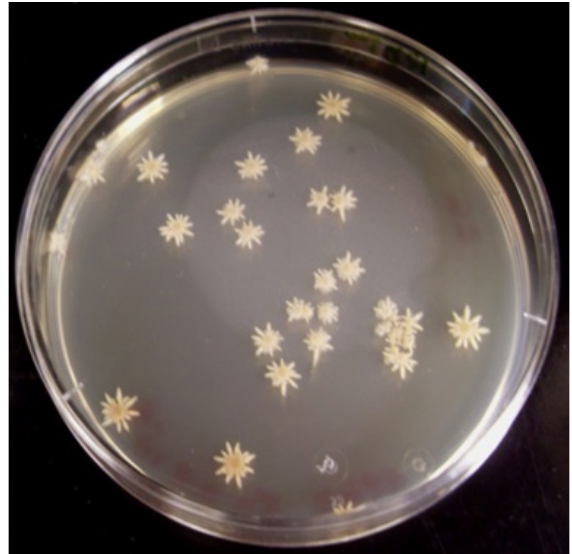
Figure 1. Morphology of P. polymyxa RNC-D strain on YPM